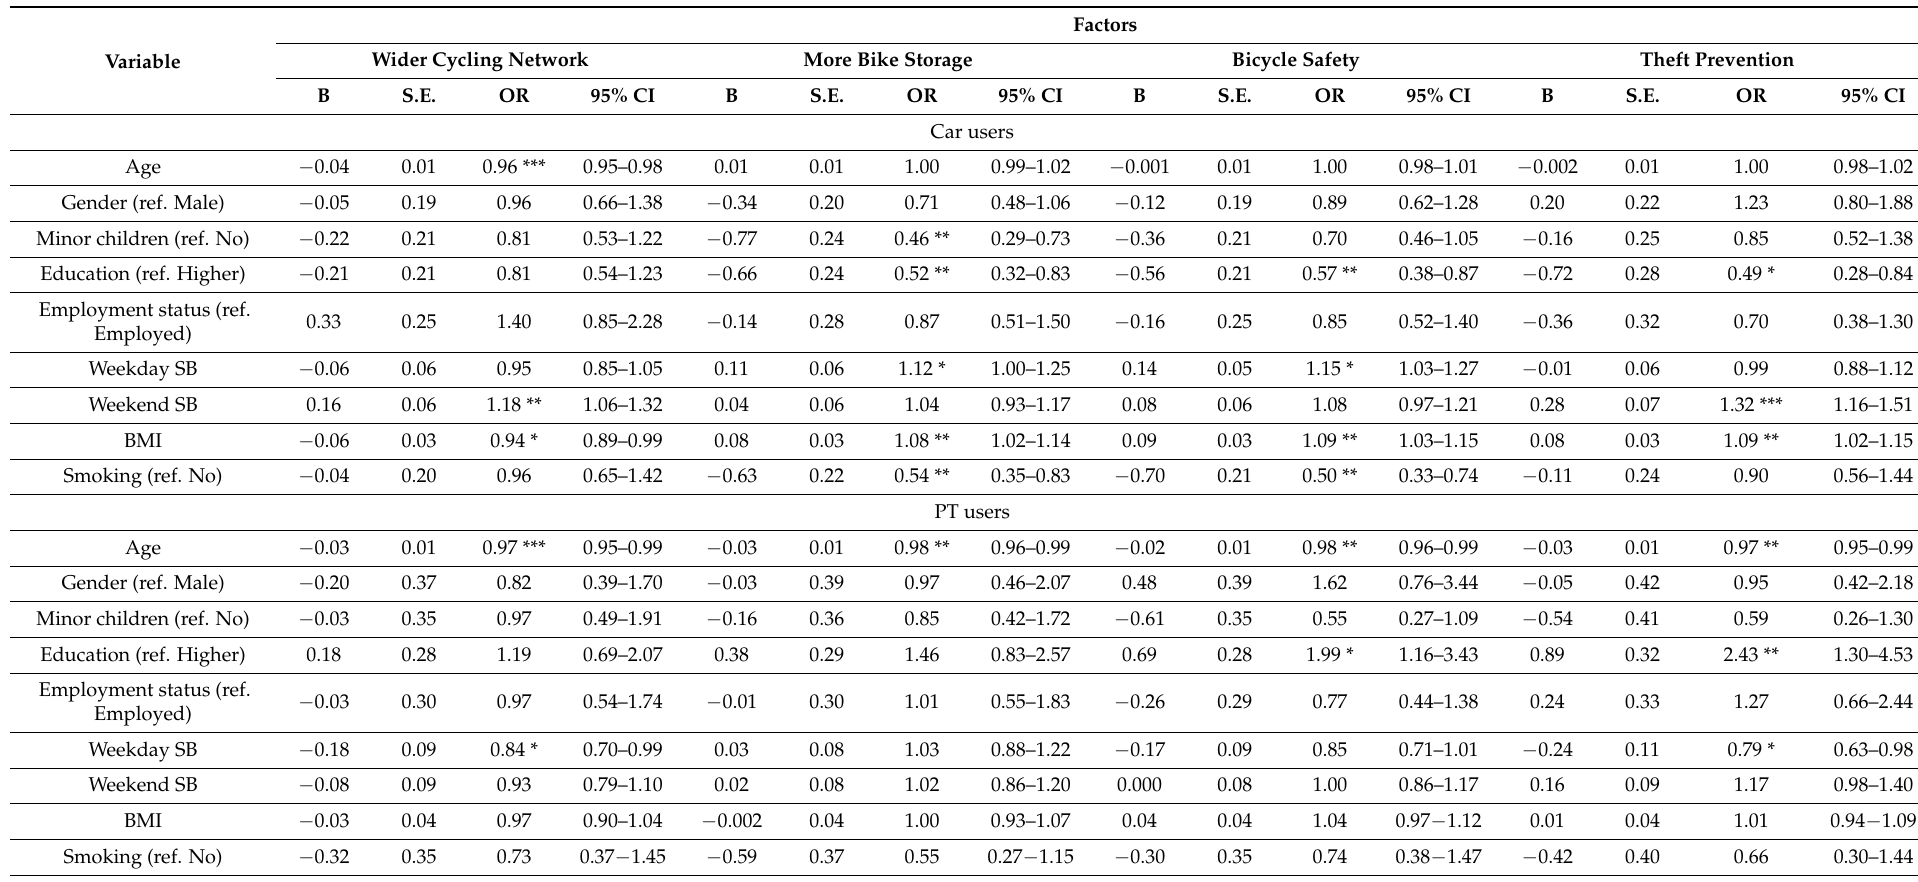
Table 5. Associations between individual characteristics of the study participants and factors encouraging cycling among car and PT